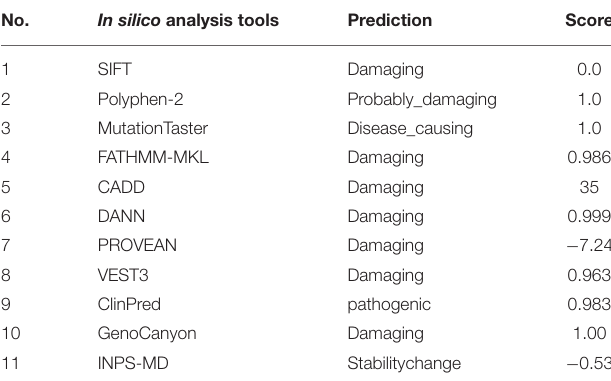
TABLE 2 | Pathogenicity prediction of the identified mutation (c.3097C > T,p.R1033C) using multiple online in silico tools.